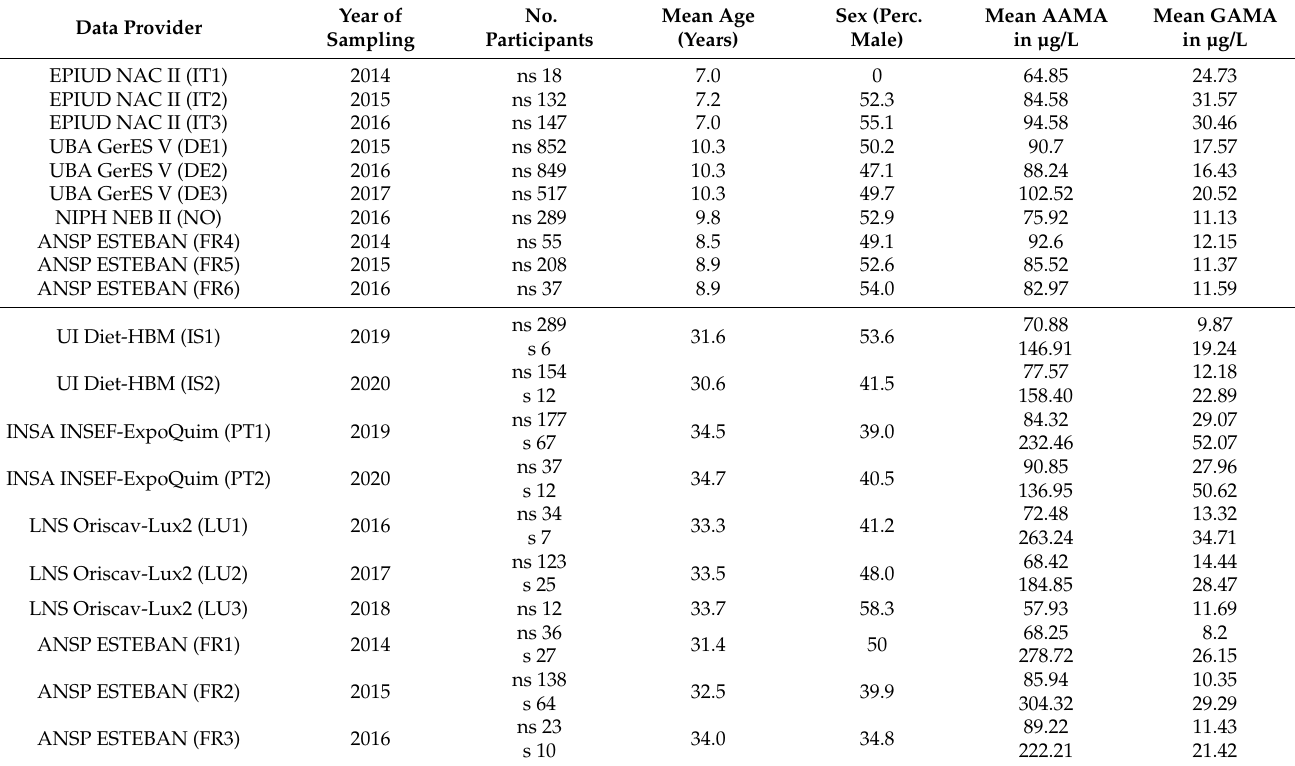
Table 2. Overview of HBM4EU Aligned Studies and bilateral data